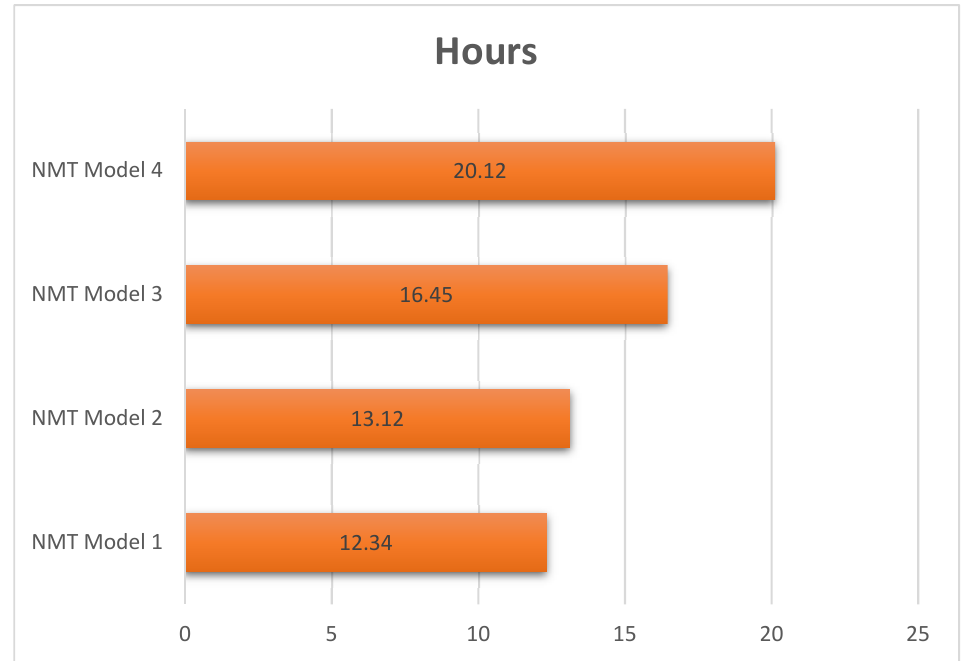
Figure 5. The training time of the NMT models.